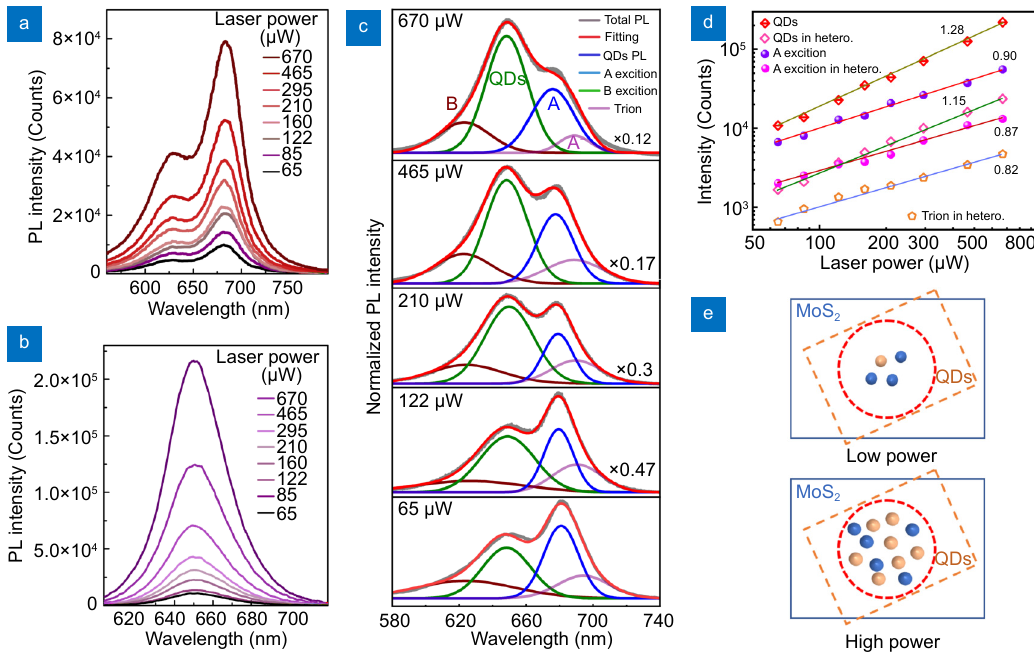
Fig. 4 | Laser-power dependent spectral modulation of QDs, MoS 2 and their heterostructures. PL spectra change of ( a ) MoS 2 monolayer and ( b ) QDs at various laser powers. ( c ) Analysis of PL spectral shapes in QD/MoS 2 heterostructure with the excitation of various laser powers. The total PL peak consists of QD exciton (green), MoS 2 exciton (A, blue), trion (A - , purple) and B exciton, and they can be fitted well in the shape of Lorentzian curves. ( d ) Plots of normalized PL intensity of exciton and trion as a function of laser powers. The relationship of PL intensity ( I ) and laser power ( P ) can be fitted as I =( P ) m . ( e ) Schematic of exciton generation and emission at low and high laser